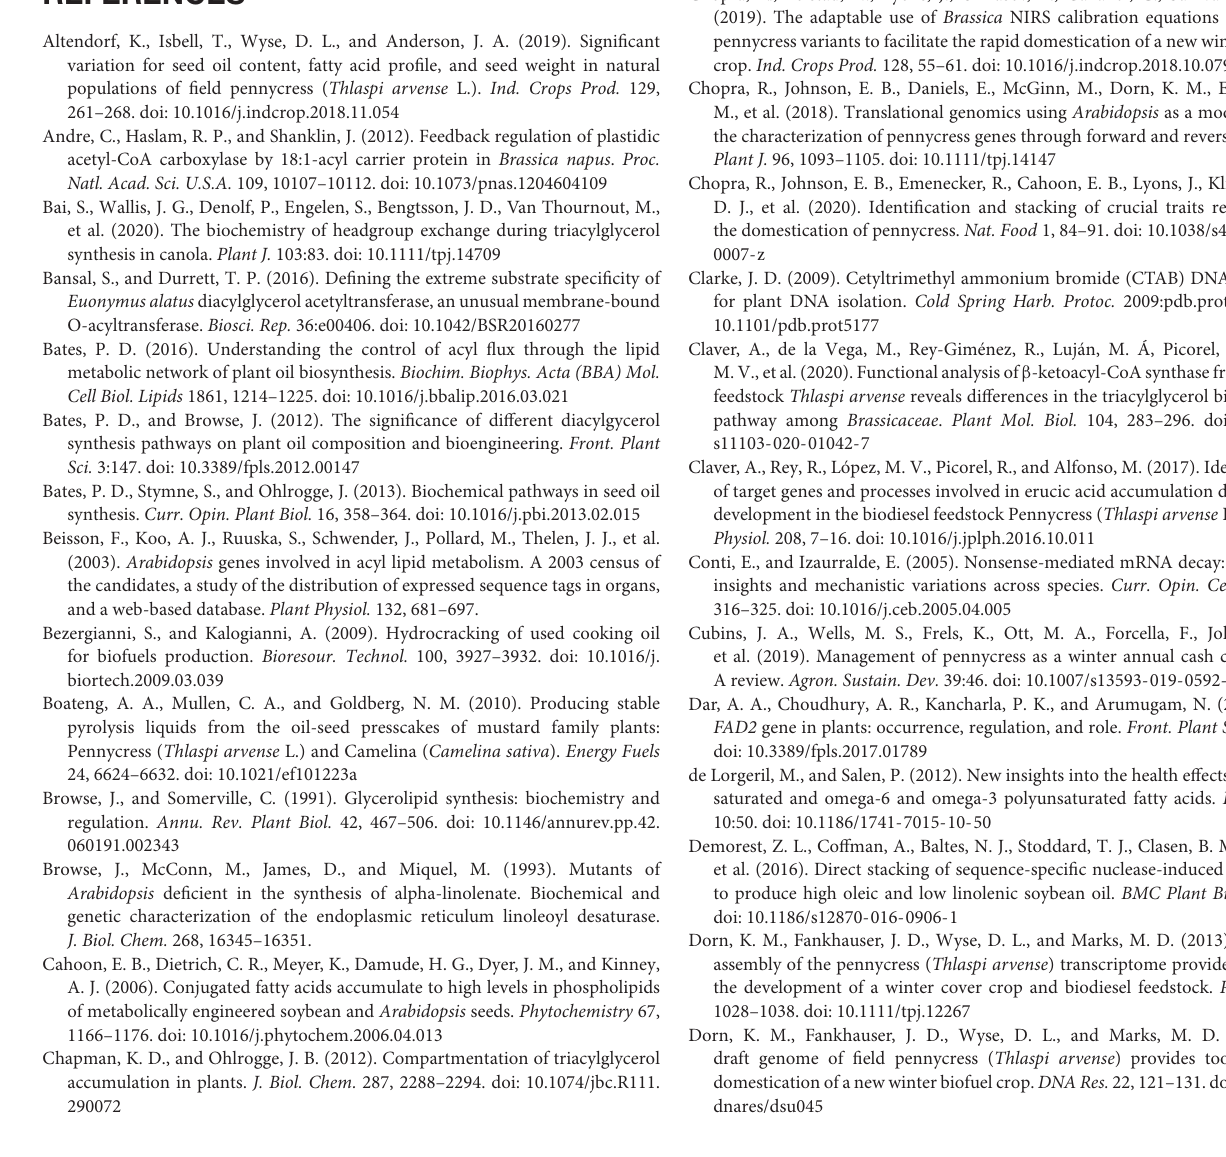
Supplementary Figure 6 | Graphed amounts of seed germination over a 16-day period under different temperatures and light regimes. Supplementary Figure 7 | MS imaging of PC molecular species detected in wild-type and mutant embryos. Supplementary Figure 8 | MS imaging of TAG molecular species detected in wild-type and mutant embryos. Supplementary Table 1 | Seed TAG fatty acid compositions of the different mutants. Supplementary Table 2 | Total seed germination on agar growth media plates. Supplementary Table 3 | Amounts of seed germination in constant light at different temperatures. Supplementary Table 4 | Amounts of seed germination in constant darkness at different